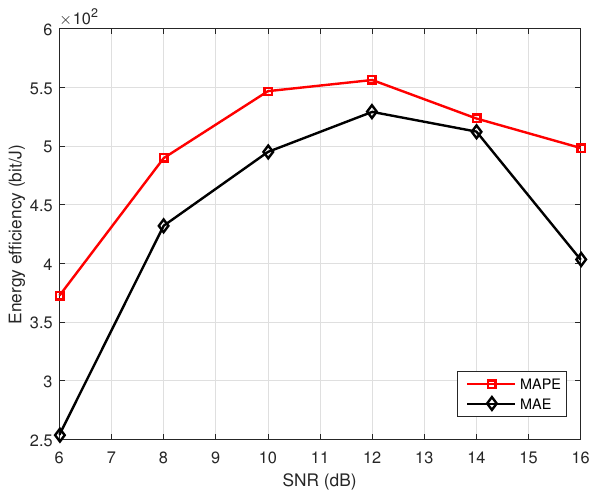
Figure 11. The performance of energy efficiency with different feedback